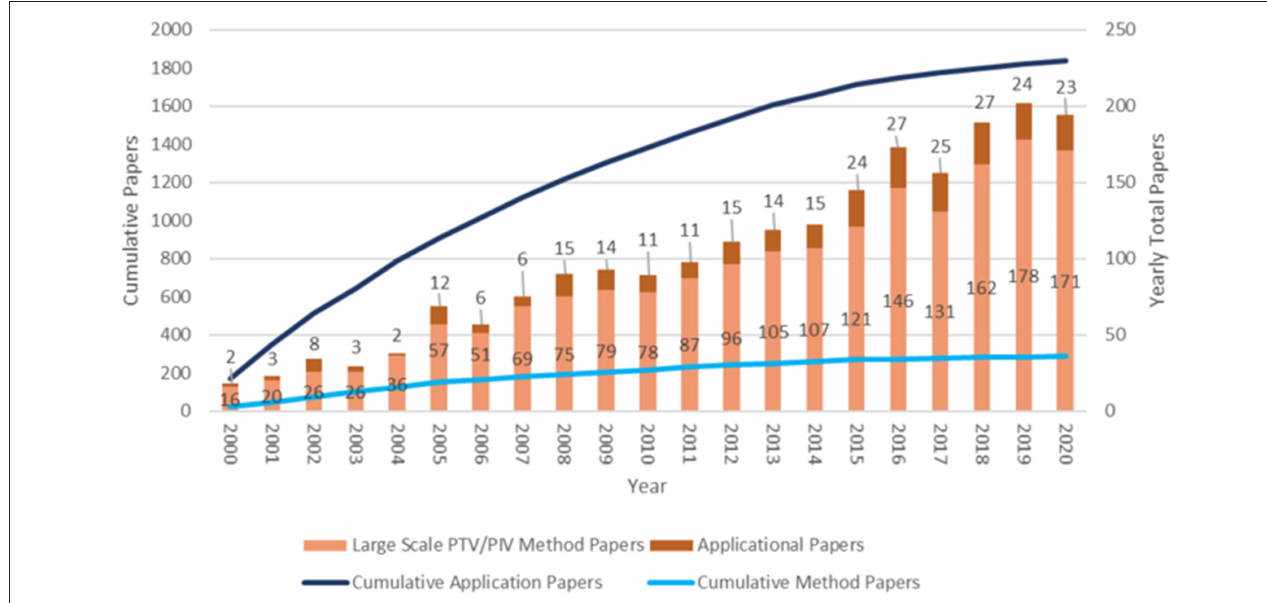
FIGURE 1 | An insight into the number of publications over the past two decades into the research of large scale PIV and PTV, compared with those focused on the application of PIV and PTV on rivers. Data found via www.webofscience.com. The following refinements were applied to the search: Total papers, topic “Surface velocimetry PIV” OR topic “Surface velocimetry PTV” AND all fields “rivers.” Application papers, topic “Surface velocimetry PIV application” OR topic “Surface velocimetry PTV application” AND all fields